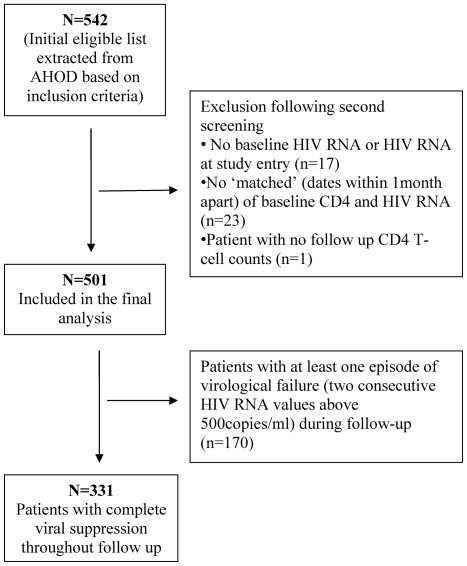
Patient disposition.